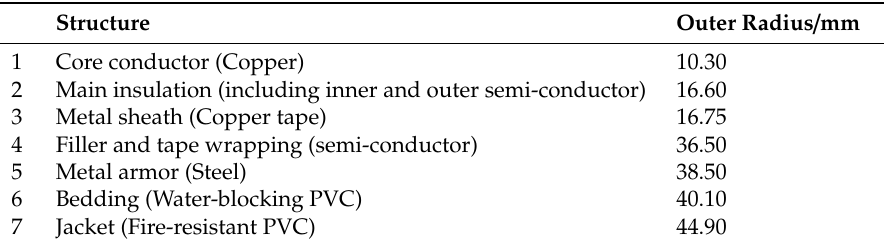
Figure 17. The configuration of a double-end bonded MV cable system: note, ‘core conductor’ has three cores, one for each phase. Table 2. Parameters of cross-sectional structure of the MV cable. Table 2. Parameters of cross-sectional structure of the MV cable.